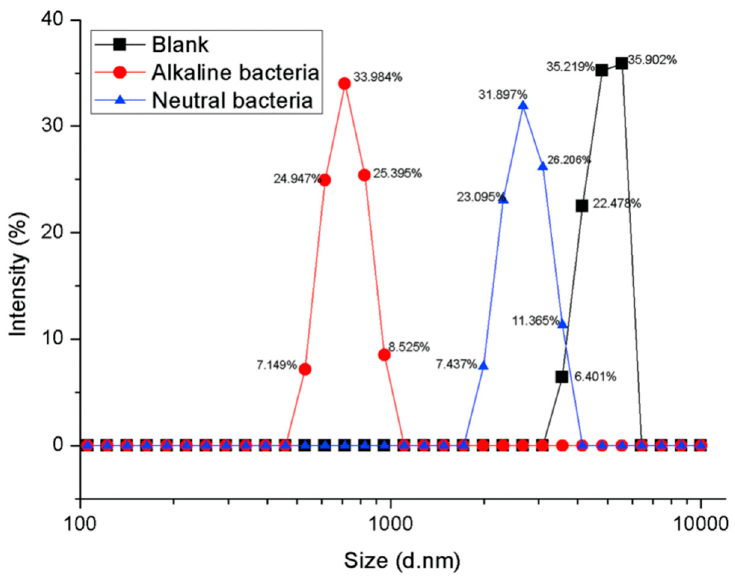
Figure 4. Changes in particle size of PET substrate after whole cell biological treatment under different pH conditions (Intensity %: the percentage of particles of different particle sizes to total particles).